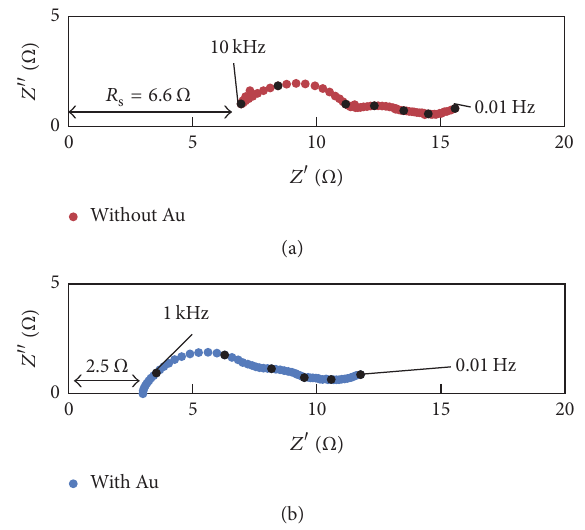
Figure 6: Nyquist plots of counter electrodes constructed without Au (a) and with Au layer (b). Black dots indicate the data recorded under each one decade of the frequency.